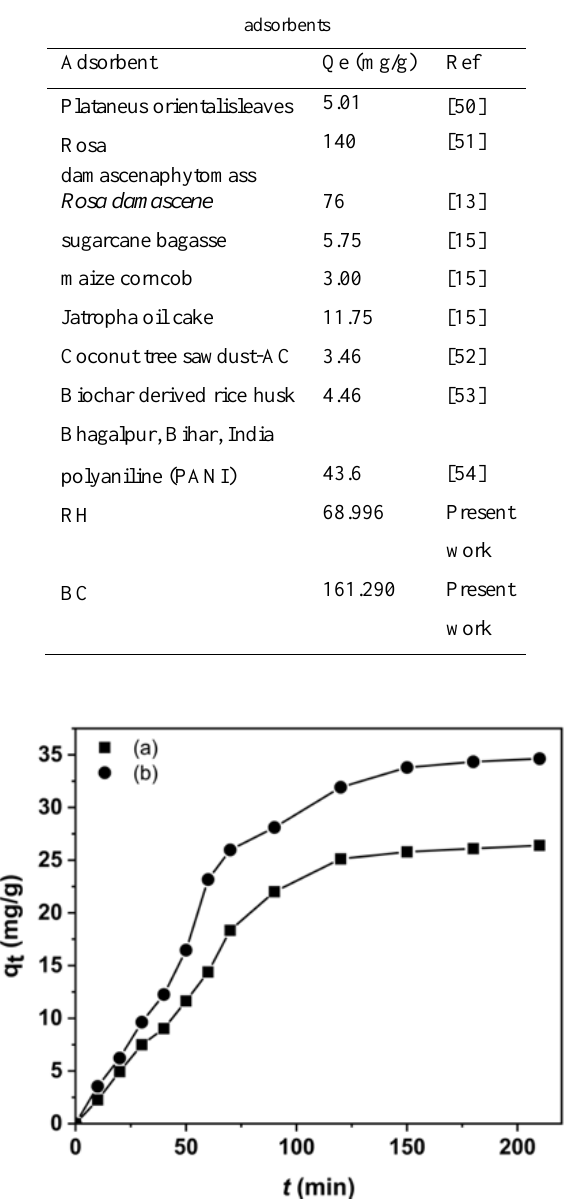
Fig. 6. Kinetic adsorption of Cr(VI) on RH (a) and BC (b); adsorbent dose = 0.25 g; volume adsorbate = 0.25 L; pH = 3.4 ± 0.1; shaking speed = 180 rpm; initial concentration = 50 mg/L; temperature condition; 303